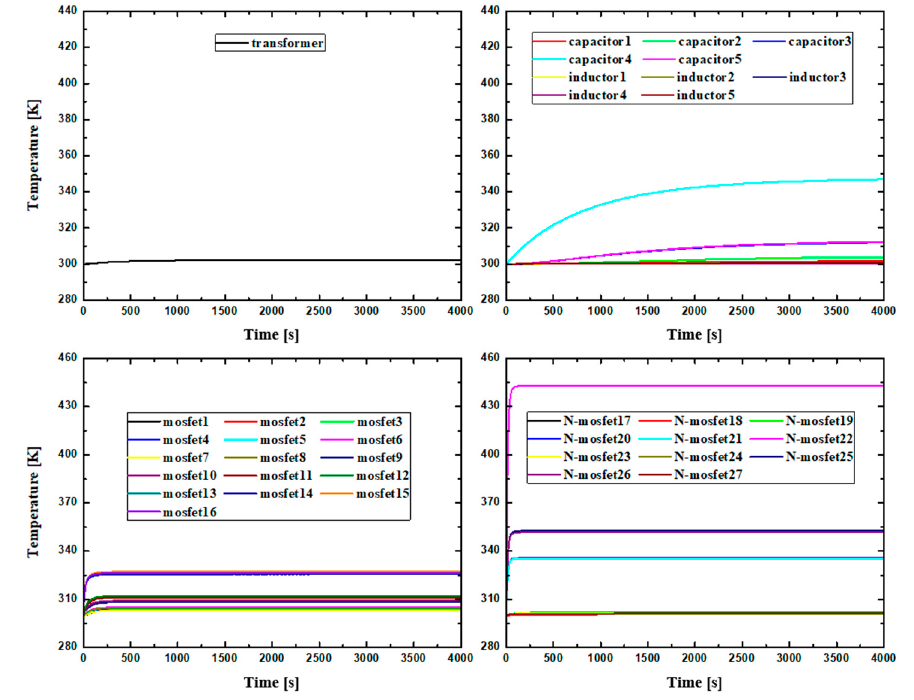
Figure 11. Temperature profile of the integrated module for a cooling water flow of 6 LPM in Operating Mode 2.